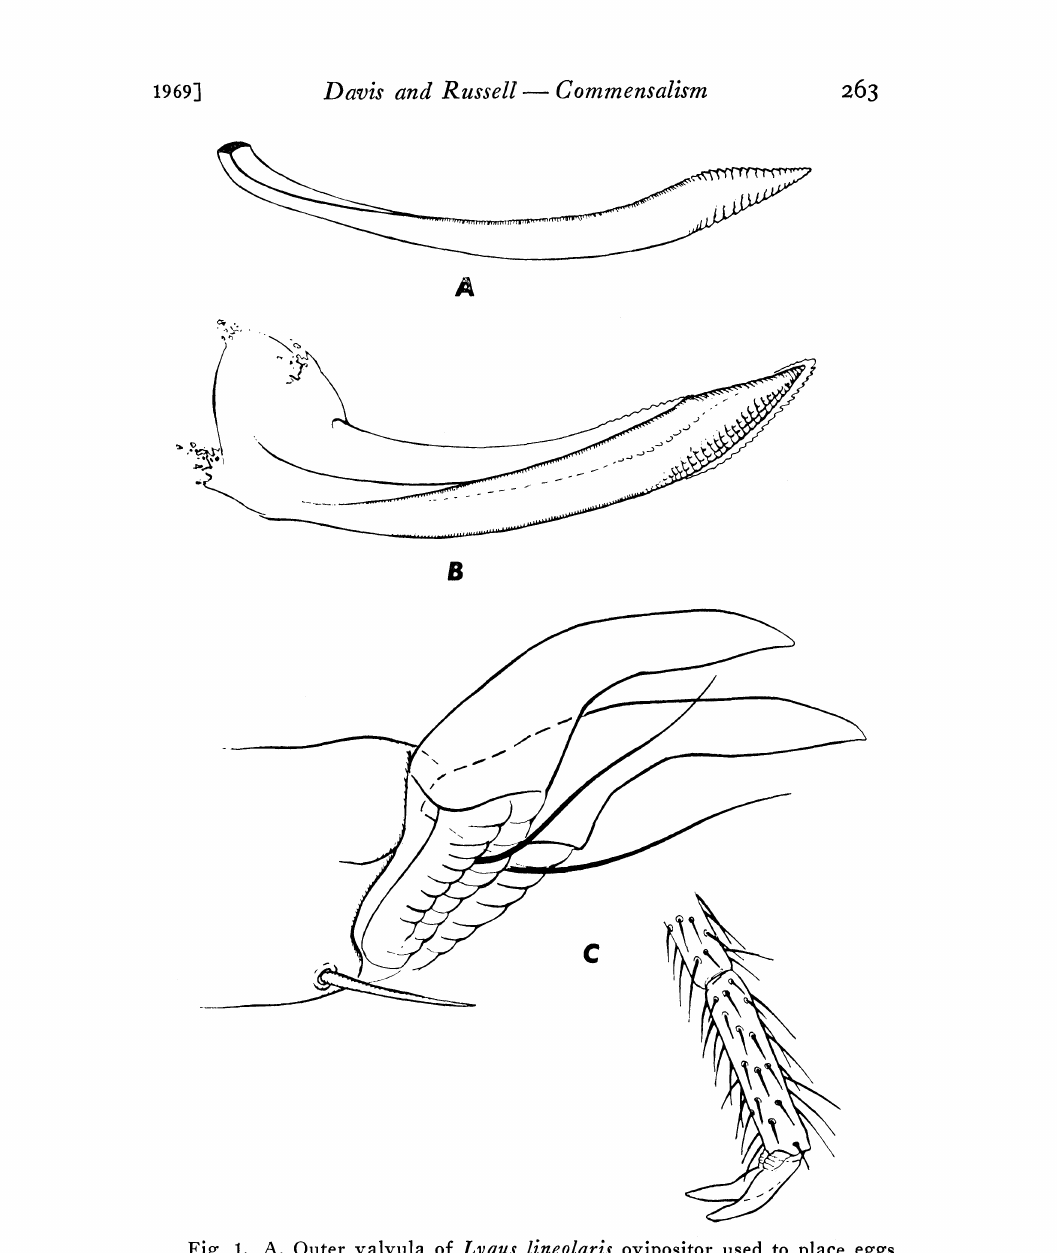
Fig. 1. A. Outer valvula of Lygus lineolaris ovipositor used to place eggs in plant tissue; B. Ovipositor of R. moerens; C. Hind tarsal claw of R. moerens showing ridged area and hooked versus extended